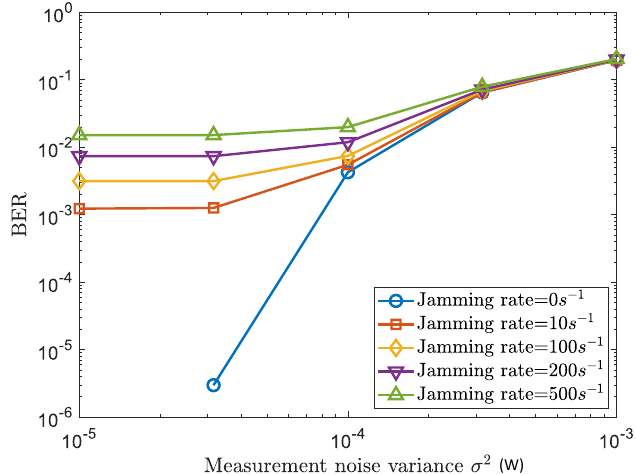
Figure 5. GLS performance with active attackers: Average BER versus physical measurement noise with different levels of jamming